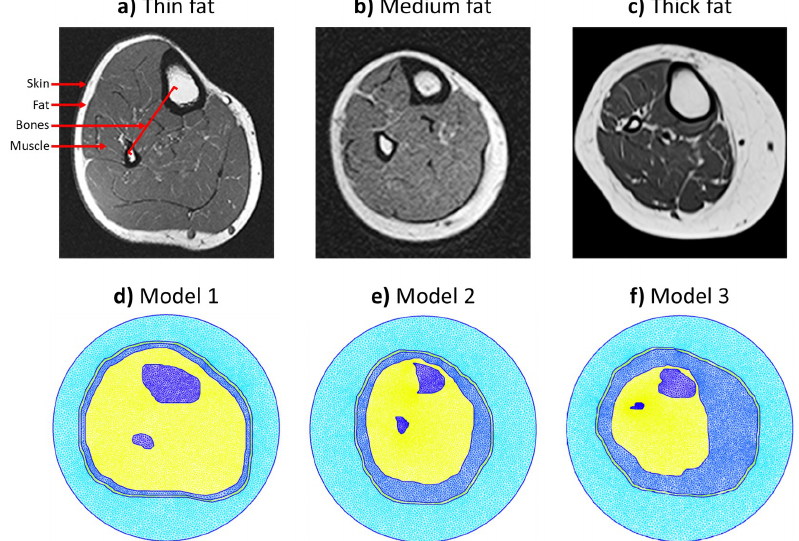
Figure 1. Generation of the three cross-sectional MRI-based anatomically-realistic leg models repre- senting three fat thickness scenarios: ( a , d ) Thin fat model 1 [27], ( b , e ) Medium fat model 2 [28], and ( c , f ) Thick fat model 3